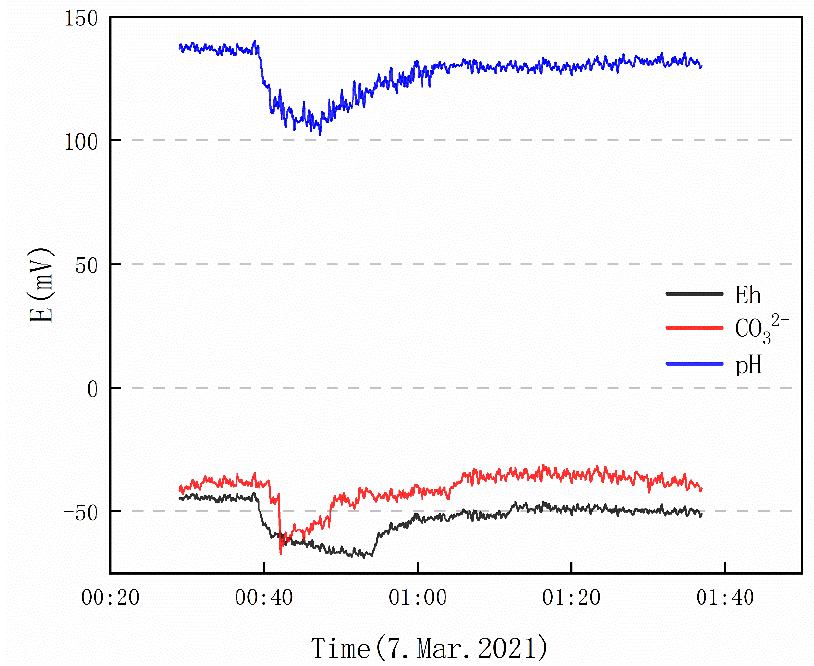
Figure 6. The pH, Eh, CO 3 2– data obtained from the MPCS during the Dayang 65